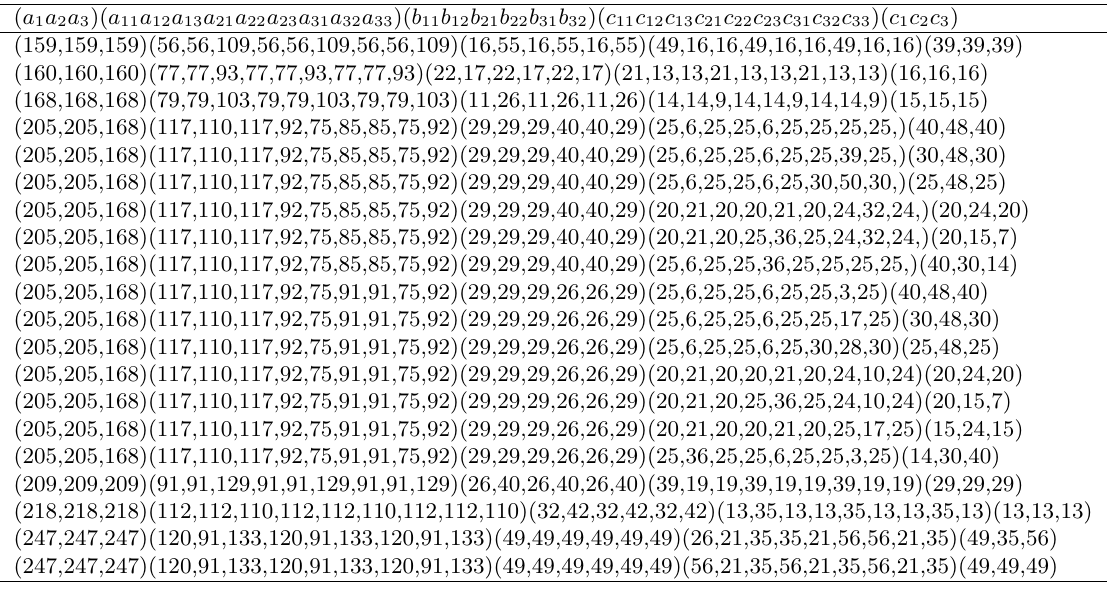
Table 1: Known primitive integral icosahedron graphs with diameter d = a 1